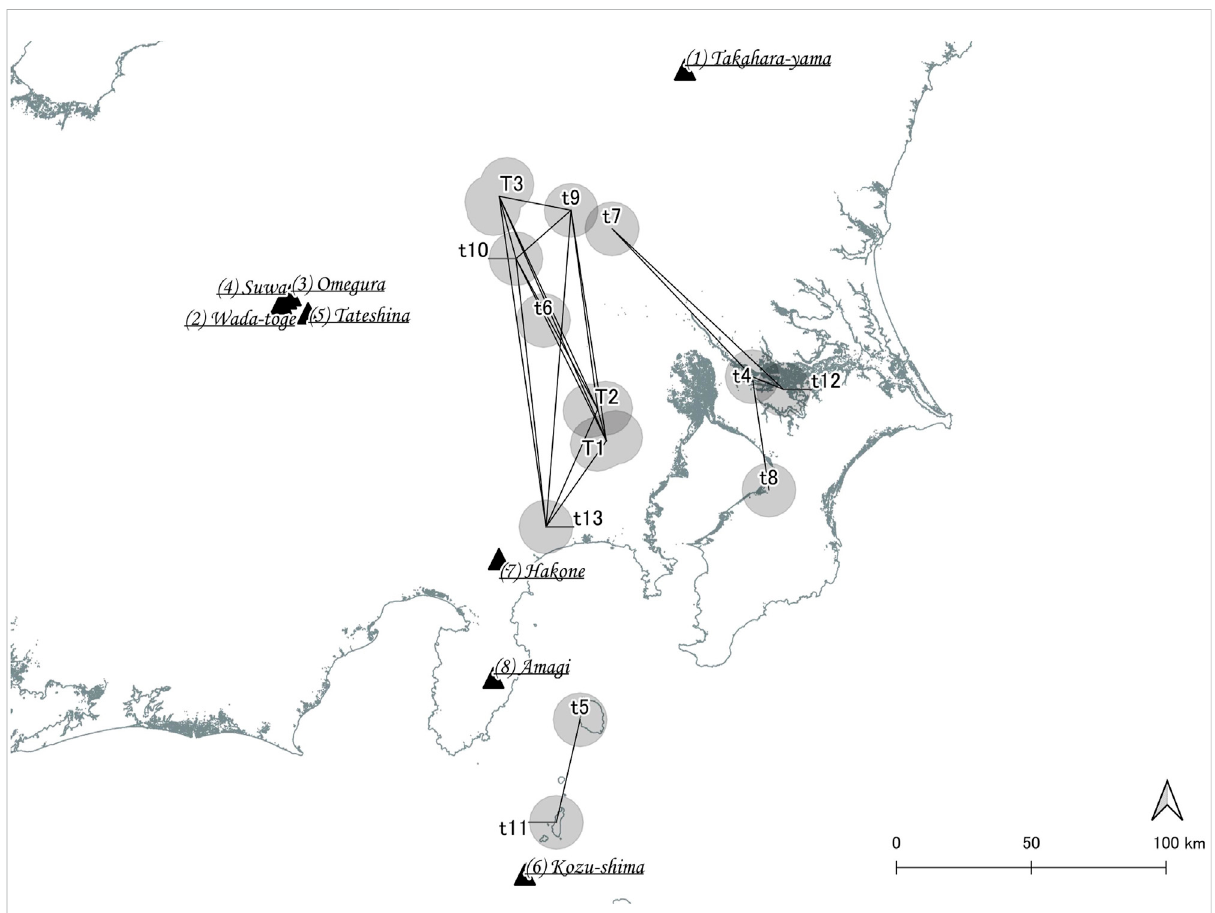
FIGURE 12 Network among consumption areas in Period 5, the last Jomon period (3,200 – 2,400 years cal BP). Clusters are represented by uppercase characters and single sites by lowercase characters. Pairs with a cosine similarity of more than 0.9 in the composition ratio of each provenance area are linked.